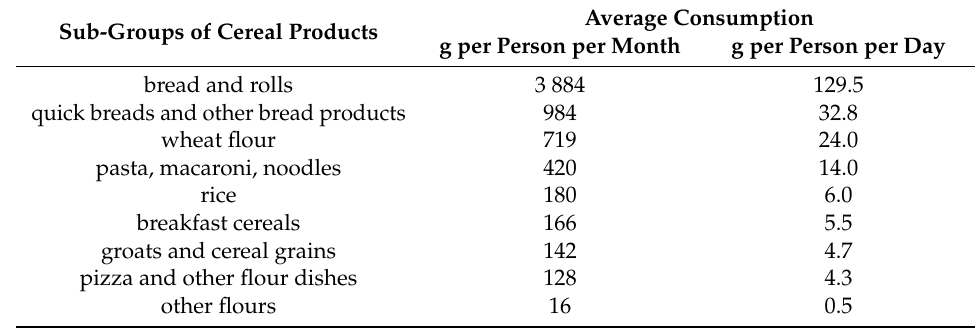
Table 2. Average consumption of cereals and cereal products in Polish